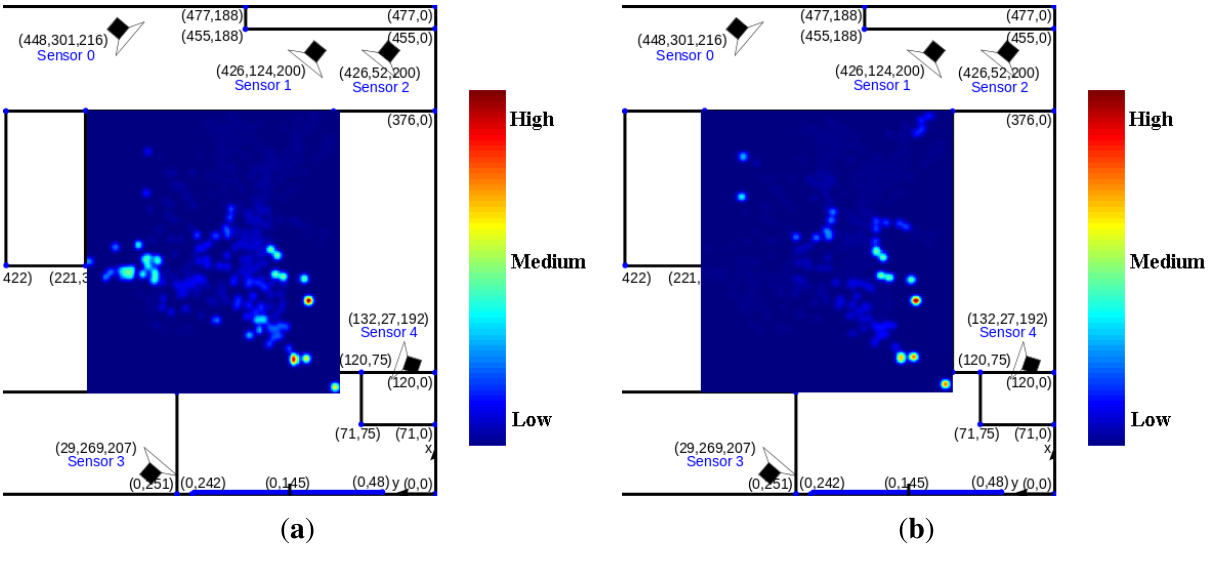
Figure 12. Average speed map computed from trajectories of ( a ) our proposed tracker (RML) and ( b ) UWB.